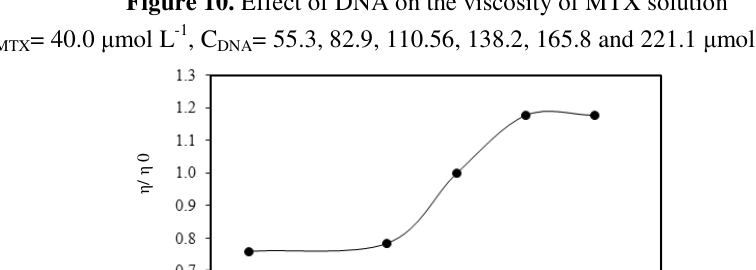
Figure 10. Effect of DNA on the viscosity of MTX solution